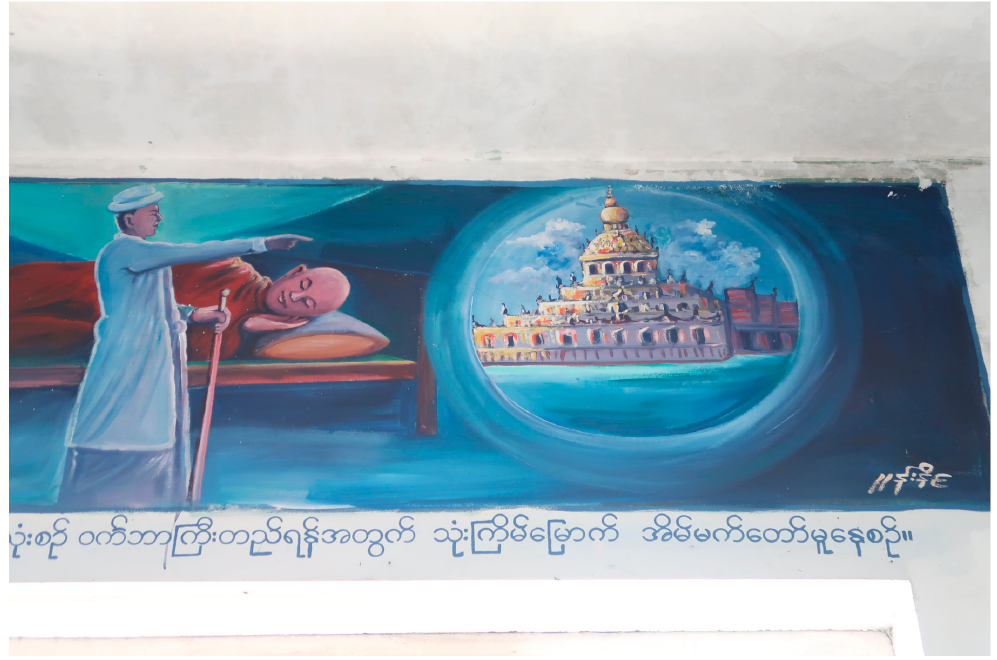
Figure 3. A painting located at the Arlein Nga Sint Pagoda in Yangon depicting the architect monk dreaming of a bodaw telling him what kind of pagoda to construct.